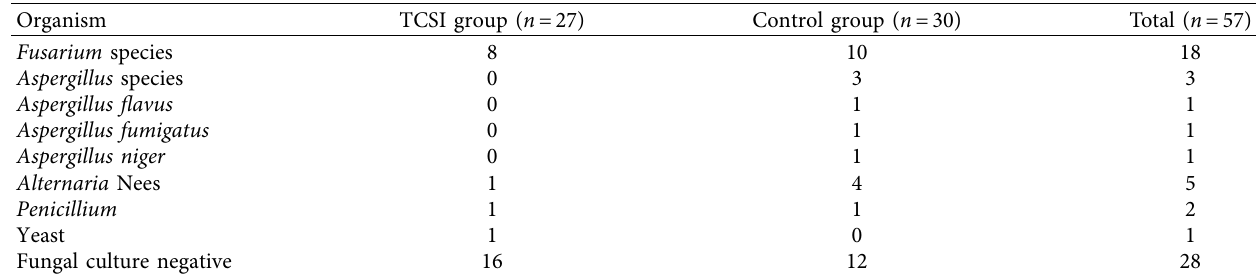
Table 2: Microbiological culture results a